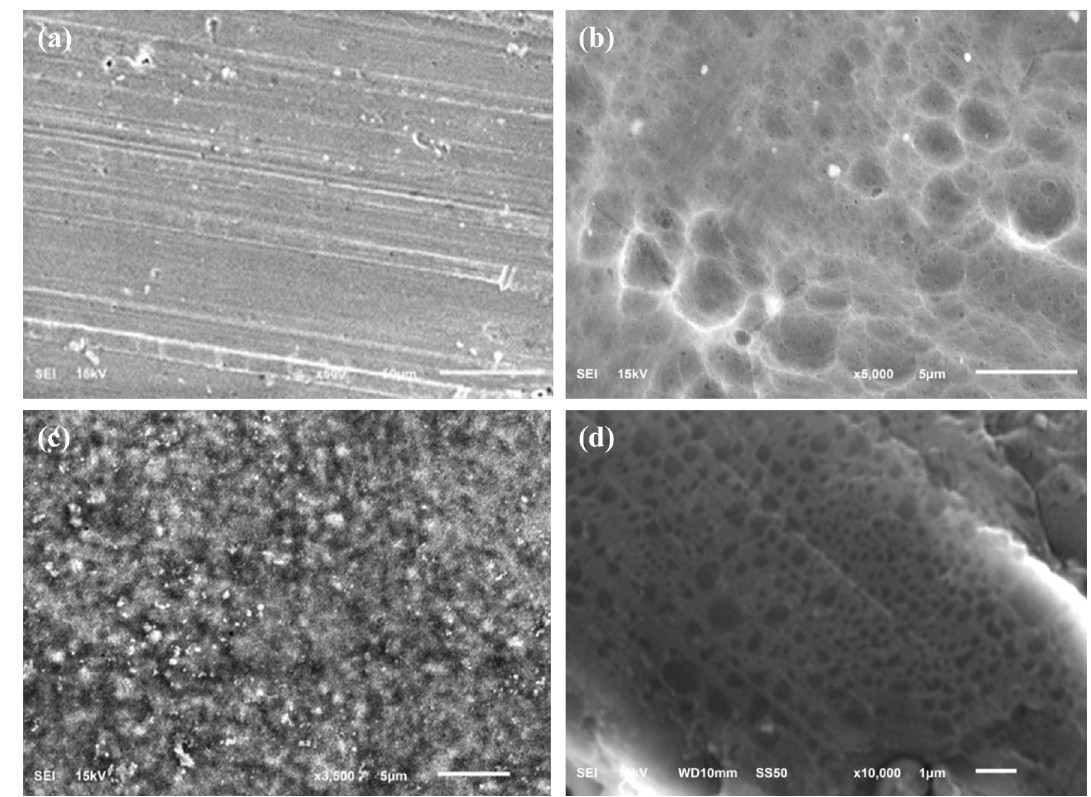
Fig. 3 SEM micrographs of a 22,024 aluminum plates, b 22,024 aluminum plates pretreated for 10 min at a power of 10 W with plasma, c spec- tra of ppy 100W-2 and d spectra of ppy 100W-